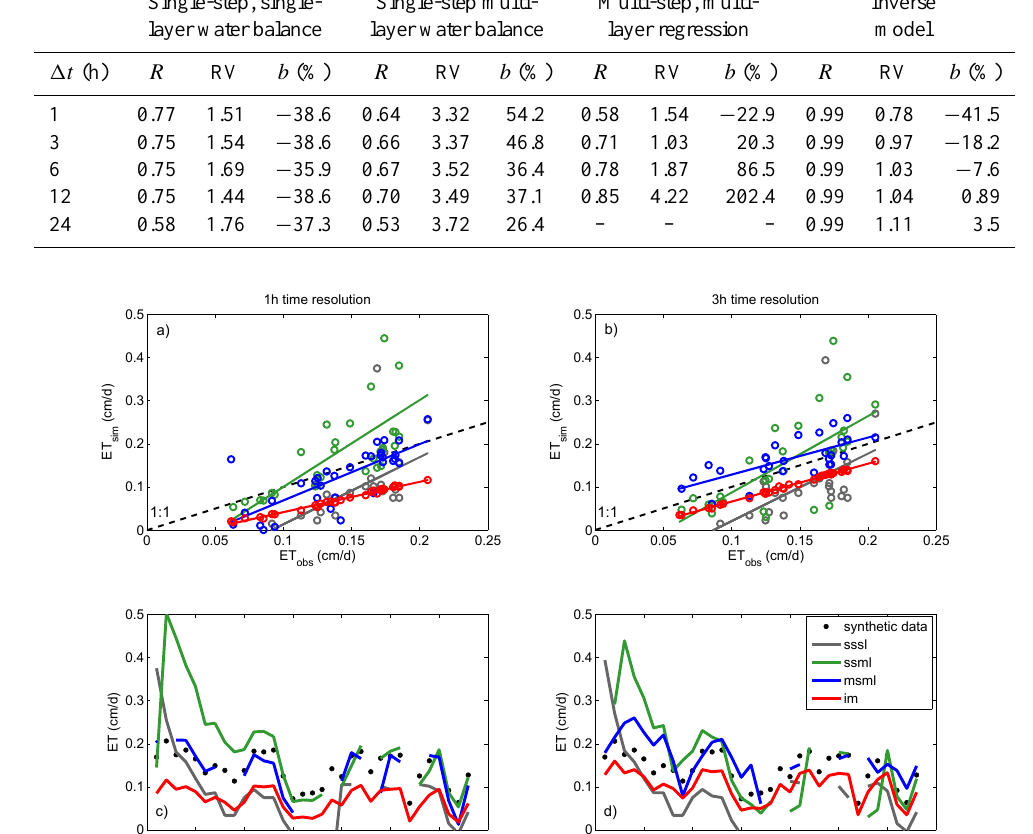
Figure 3. Top: comparison of synthetic (ET obs ) and estimated (ET sim ) values of daily evapotranspiration for hourly (a) and 3-hourly (b) ob- servation intervals of soil water content measurements. Bottom: comparison of synthetic and estimated time series of daily evapotranspiration (ET) for hourly (c) and 3-hourly (d) observation intervals of soil water content measurements (25 July to 26 August 2009). Missing values are times when rainfall and percolation appeared. An estimation of evapotranspiration was not possible with the single-step, single-layer (sssl) water balance; the single-step, multi-layer (ssml) water balance; or the multi-step, multi-layer (msml) regression for these